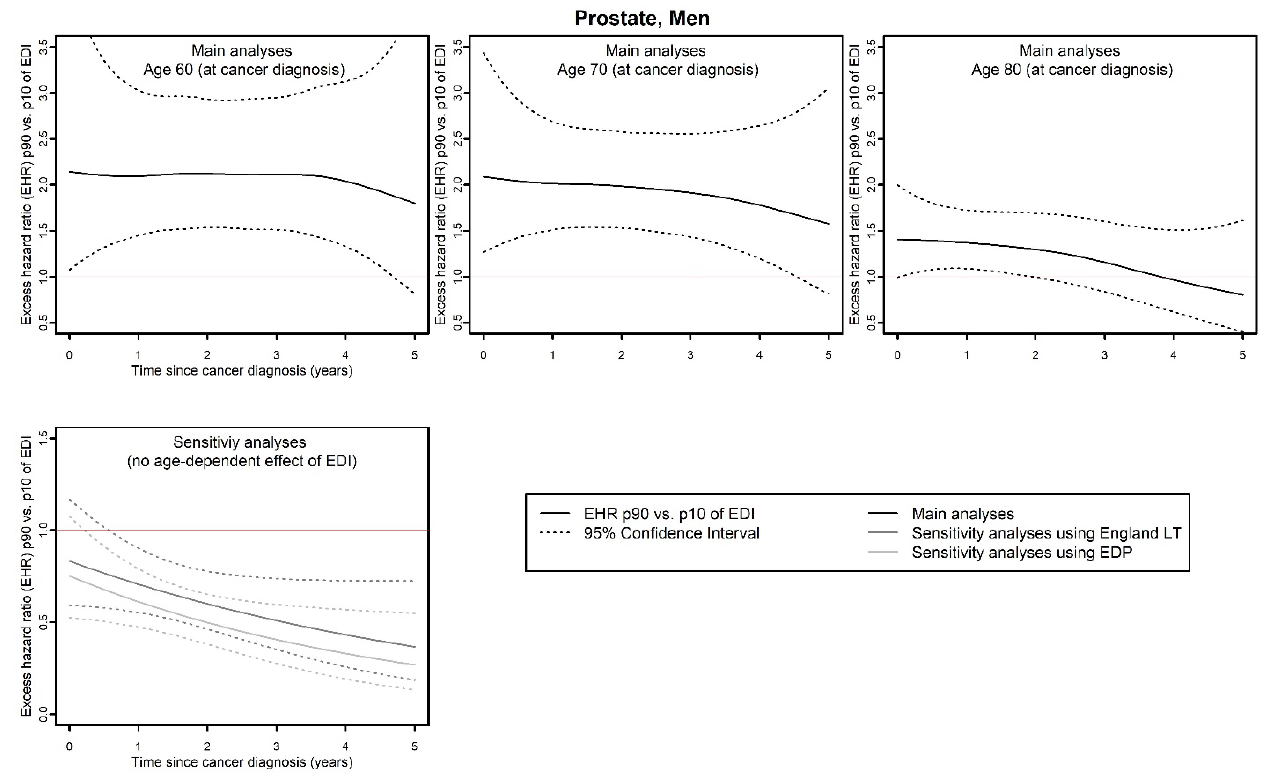
Figure 5. Excess mortality hazard ratio (EHR) between the 90th and the 10th percentile of the na- tional distribution of EDI, as a function of time since cancer diagnosis and according to the main and sensitivity analyses, for prostate cancer (discordant results between main and sensitivity anal- yses). EDI: European Deprivation Index; EDP: French permanent demographic sample [Echantillon Démographique Permanent]; EHR: excess mortality hazard ratio; LT: life tables; p90, p10: 90th and